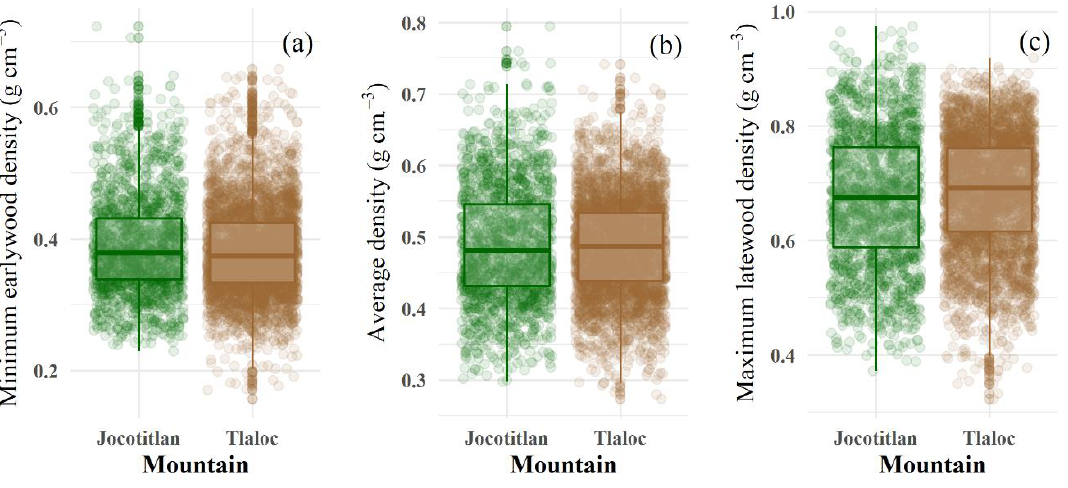
Figure 2. Boxplot of tree-ring wood density at two high-elevation forests in central Mexico ( a ) minimum earlywood density—MID, ( b ) average density—AVE, and ( c ) maximum latewood density—MXD. Note that for all cases the mean values were statistically similar.